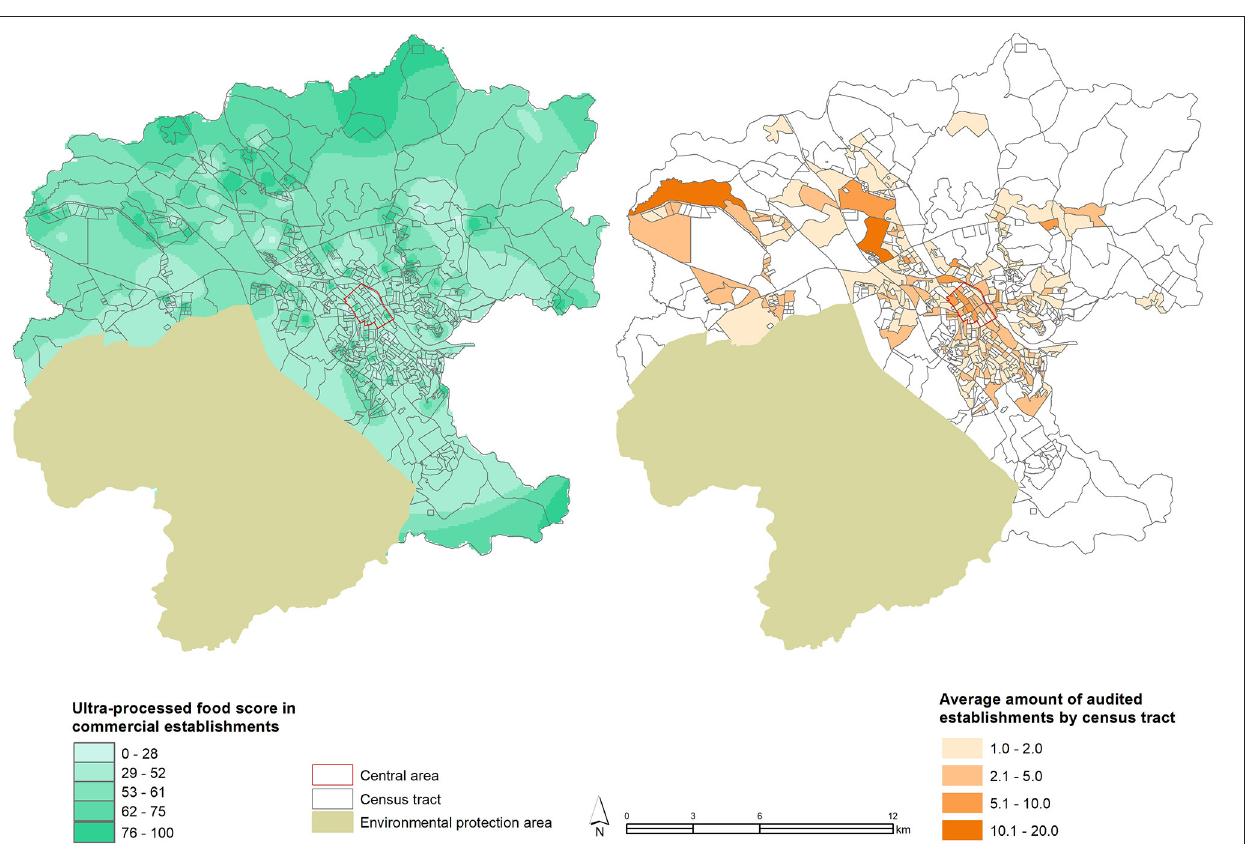
FIGURE 2 | Ultra-processed food availability score and number of establishments audited in the census tract of the municipality of Jundiaí, SP, Brazil, 2017–2018.